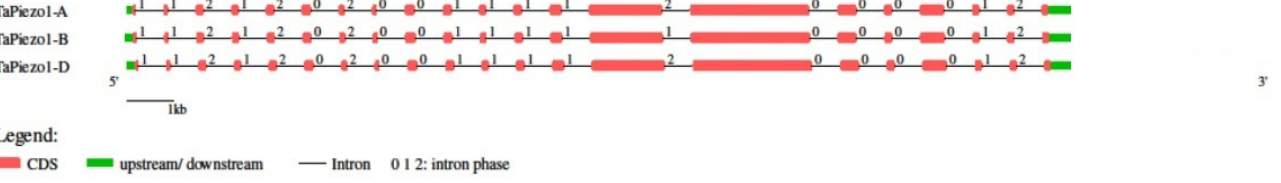
Figure 3. Gene structure analysis of TaPiezo genes. The figure represents the exon–intron organization and intron phase distribution in each TaPiezo gene, generated by the GSDS 2.0.